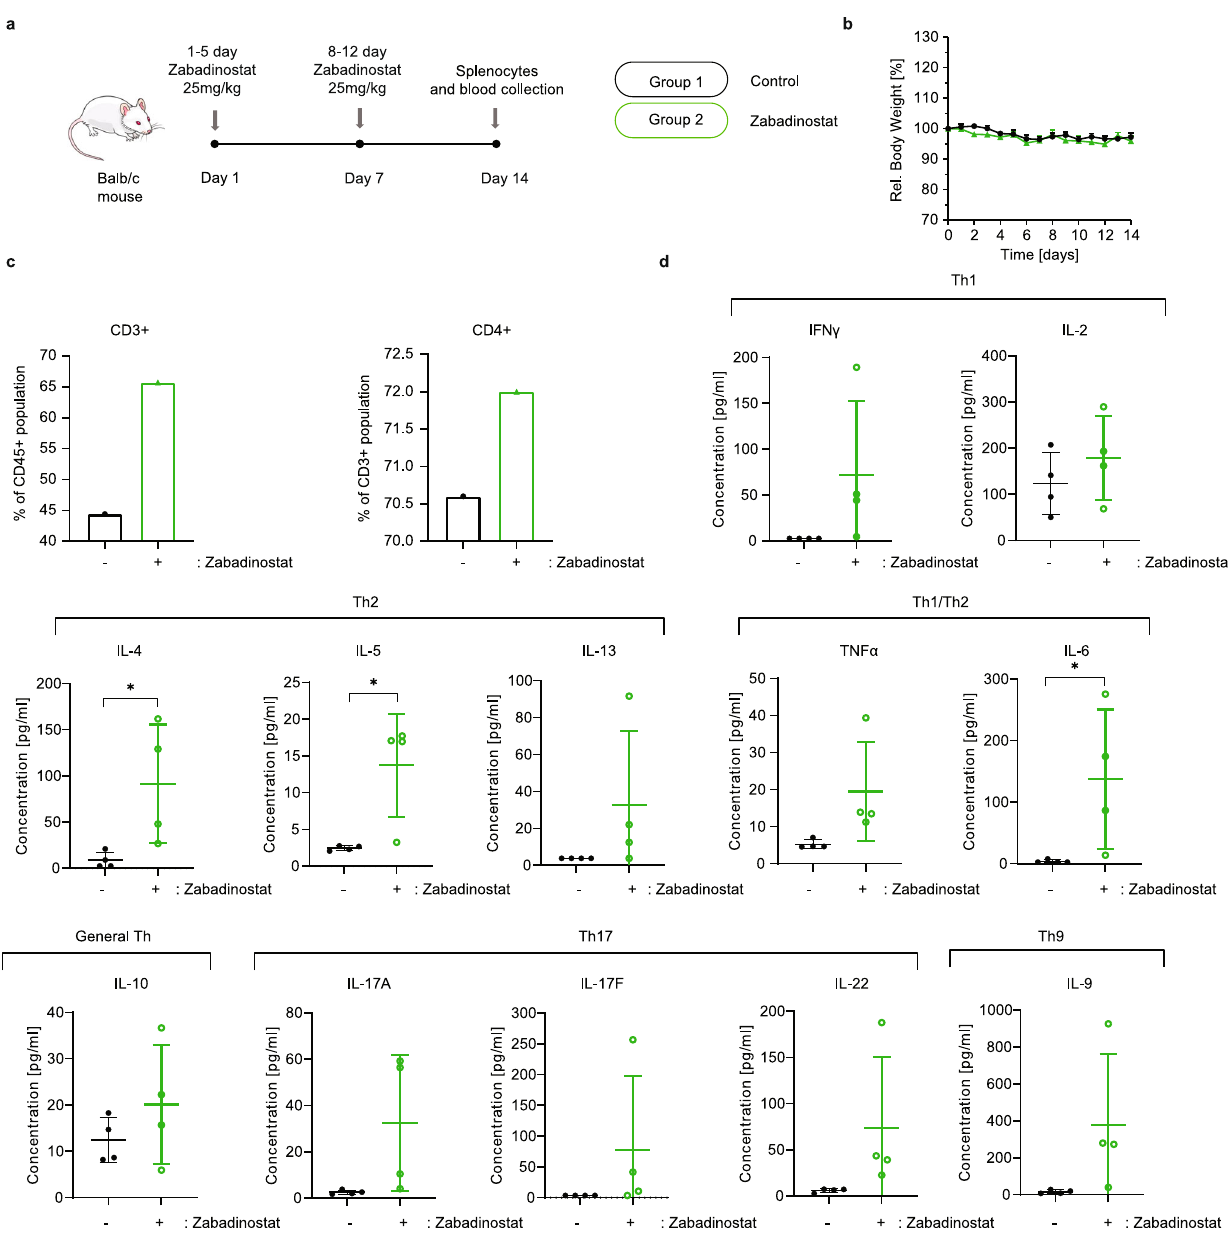
Fig. 5 Zabadinostat enhances the CD4 T-cell response. a Schematic representation of the experiment with zabadinostat. Balb/c mice were treated with orally administrated zabadinostat at 25 mg/kg for 14 days (5 days on/2 days off) or vehicle only; n = 4 per group; b relative body weight representation of treated and non-treated mice; n = 4; results presented as mean values + / − SD. c General T-cell activation and CD4-positive T cells measured by fl ow cytometry; measurements were performed in pooled splenocytes from four mice; also, we noticed similar percentage of CD8-positive T cells in control and zabadinostat-treated groups (26.2% and 24.3%). The viability of the splenocytes was similar in zabadinostat treatment compare to untreated control (70.9% and 76.6% viable cells, respectively). d Analysis of panel of Th1, Th2, Th1/Th2, General Th, Th17 and Th9 cytokines in serum collected from mice treated with zabadinostat and the control group; n = 4; results presented as mean values + / − SD; Student ’ s t